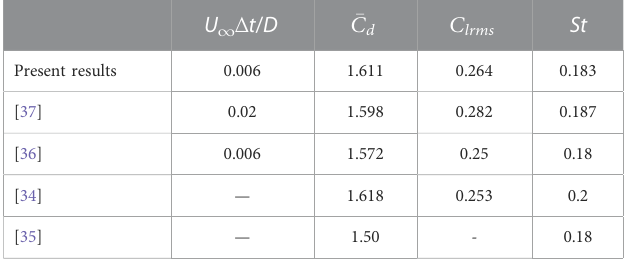
TABLE 1 Comparison of main fl ow quantities at Re = 2 × 10 5 .